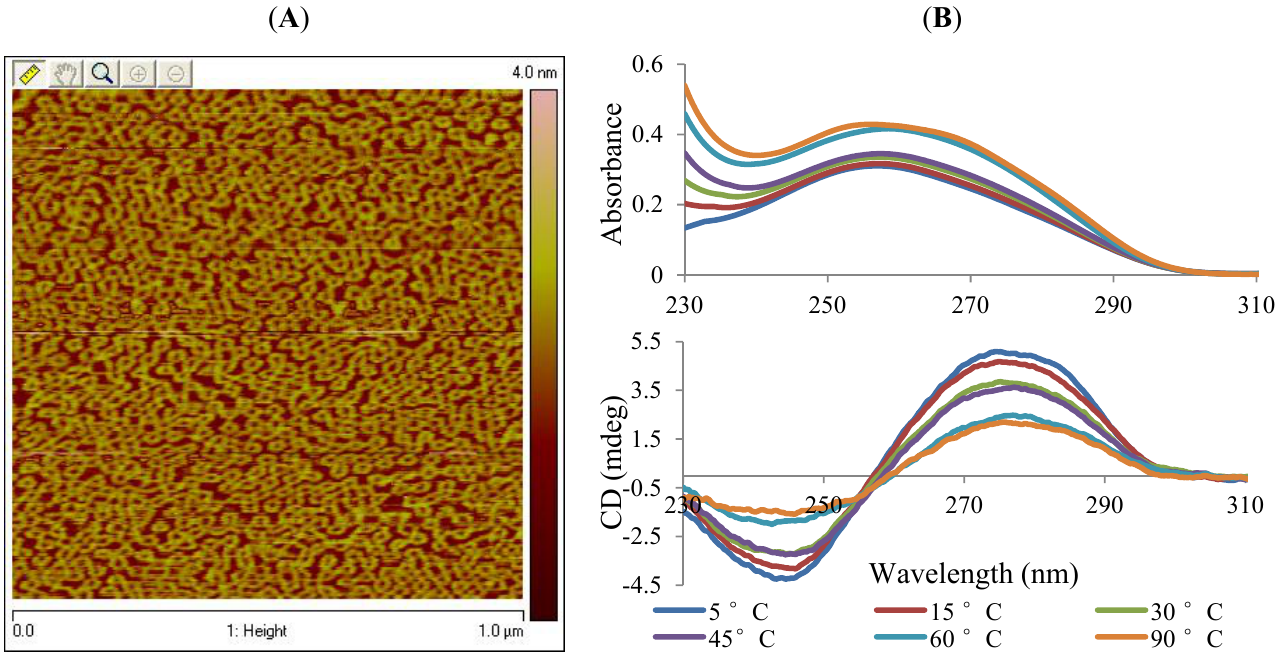
Figure 2. wwDNA formation monitored via surface (2A) and solution (2B) techniques ( A ) AFM of sample prepared by surface mediated assembly of wwDNA architecture on freshly cleaved mica in aqueous solution (TAE-Mg 2+ ); ( B ) CD and UV spectroscopy of wwDNA in aqueous solution with respect to increasing sample temperature; where TAE is Tris-Acetate-EDTA. ( A ) ( B